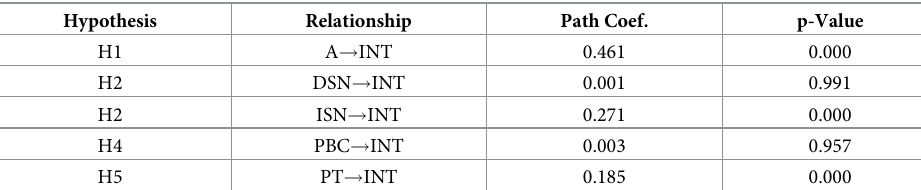
Table 6. Results of hypotheses testing for vaccination intention.